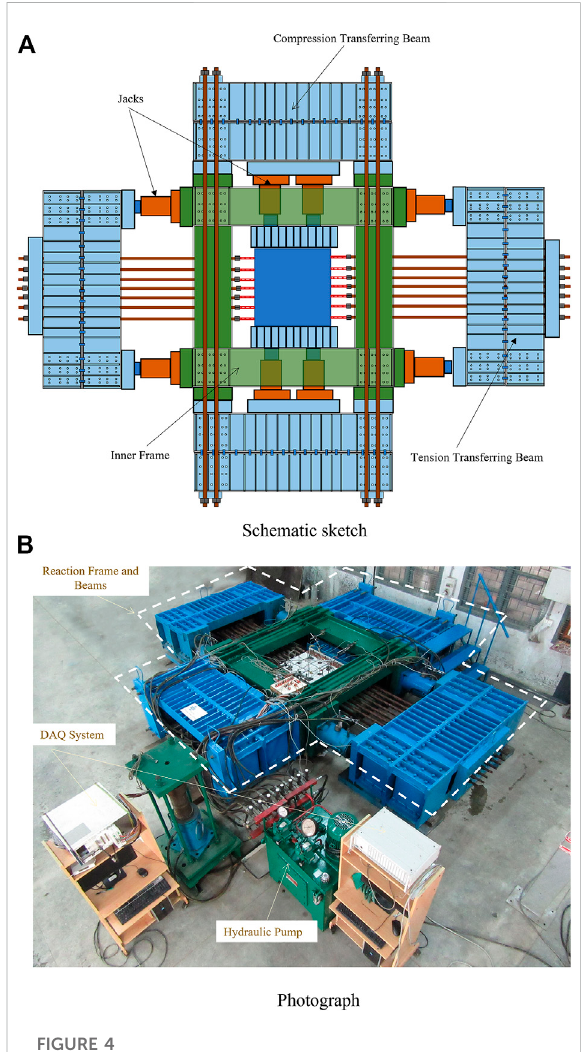
FIGURE 4 Test setup. (A) Schematic sketch. (B) Photograph.